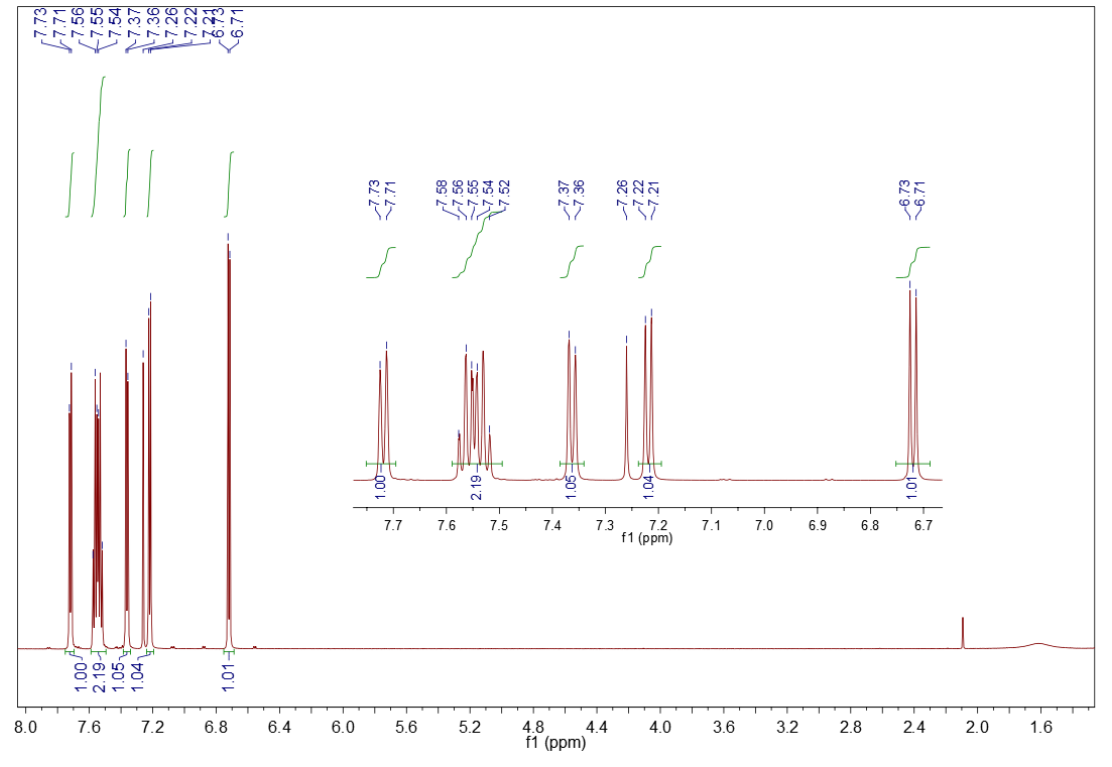
Figure 6. 1 H NMR spectrum of sediment precipitated from the surrogate kerosene. Sample of 10 mg in 0.7 mL deuterated chloroform, 600 MHz.